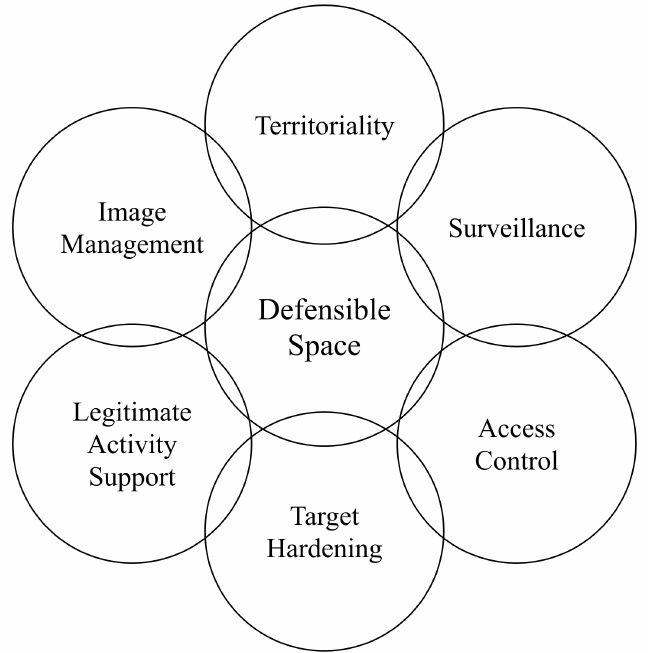
Figure 1. The 1st Generation Crime Prevention through Environmental Design (CPTED) and the seven principles: defensible space, access control, territoriality, surveillance, target hardening, image, and activity